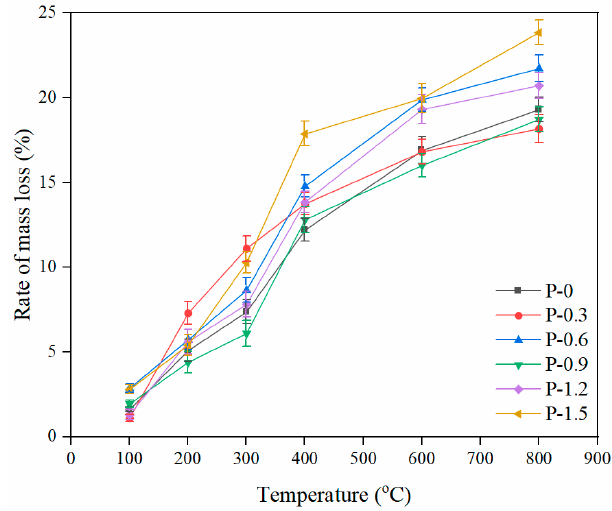
Figure 3. Mass loss rate of PVA-FRCC specimens after exposure to different temperatures. The mass loss rate of the specimen with a PVA fiber content of 0.9% is slightly lower than that of reference specimen. When the PVA fiber content is 1.2% and 1.5%, the ag- glomeration of the fibers makes the mixing uneven, resulting in an increase in the internal